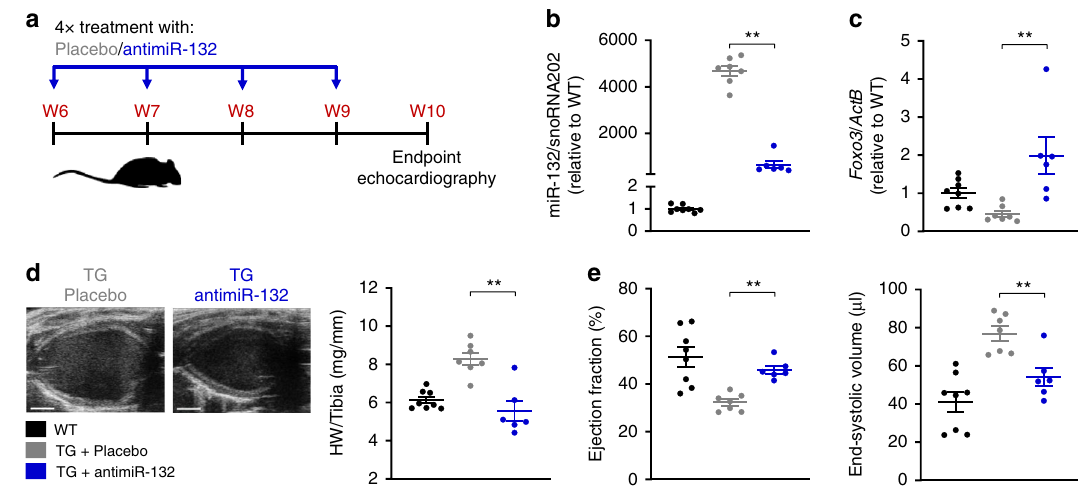
Fig. 1 Therapeutic potential of antimiR-132 treatment. a Study outline of antimiR-132 application (20 mg/kg, i.p.) to miR-212/132 transgenic (TG) mice compared to placebo treatment (0.9% NaCl solution) and wildtype (WT) mice. b Functional miR-132 level. c MiR-132 target gene expression (Forkhead Box Protein O3, Foxo3 ). d Representative images of the parasternal long axis (PLAX) view of the left ventricle (LV) (scale bar = 2 mm) and heart weight (HW) vs. Tibia length ratio of mice. e Echocardiographic evaluation of ejection fraction and end-systolic volume. WT: n = 8, TG + NaCl: n = 7, TG + antimiR-132: n = 6. Data are mean ± s.e.m; ** P < 0.01; unpaired two-sided Mann – Whitney U